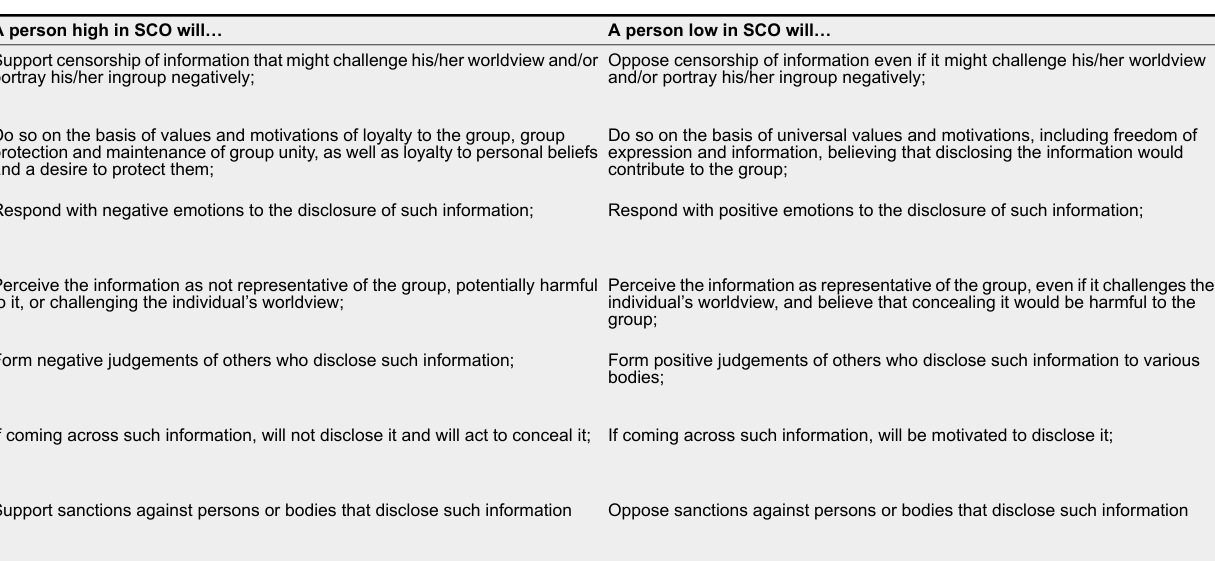
Mapping Sentence of Self-Censorship Orientation (SCO) negatively;Supportcensorshipofinformationthatmightchallengehis/herworldviewand/or portray his/her ingroup negatively;